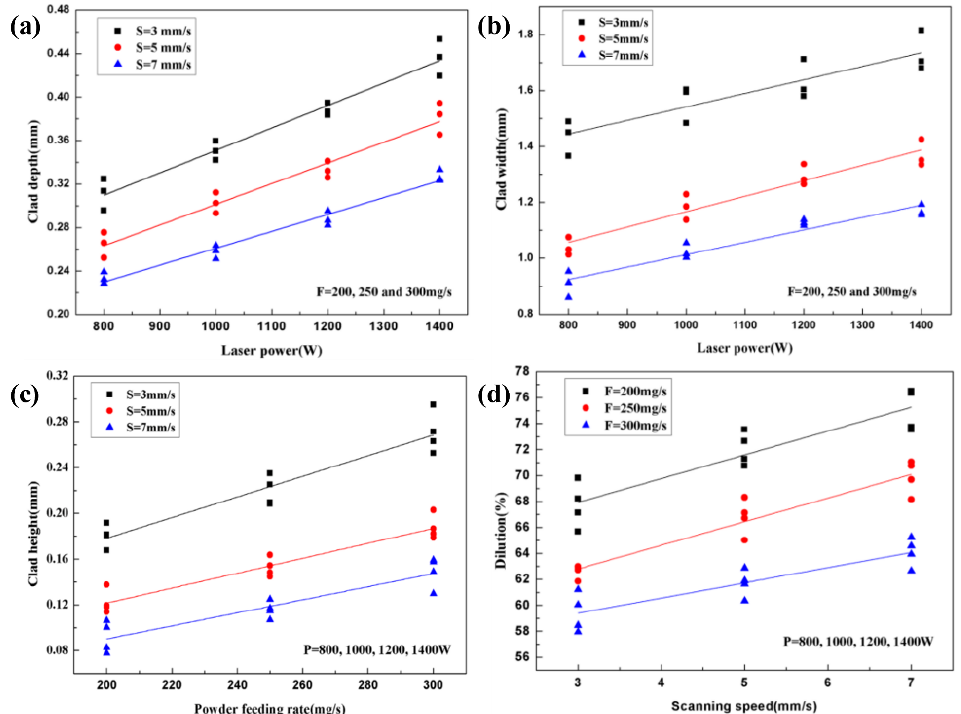
Figure 5. Influence of main processing parameters on geometrical characteristics of single-pass cladding: ( a ) the effect of the main processing parameter on the clad depth; ( b ) the effect of the main processing parameter on the clad width; ( c ) the effect of the main processing parameter on the clad height; ( d ) the effect of the main processing parameter on the dilution rate [73]. Reprinted with the kind permission of MDPI.